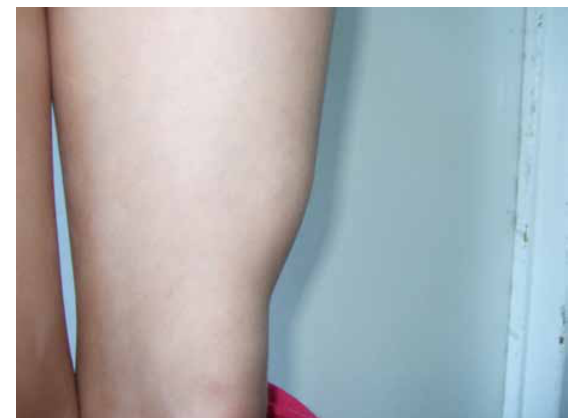
Figure 1. Presence of the lesion deforming the left thigh.